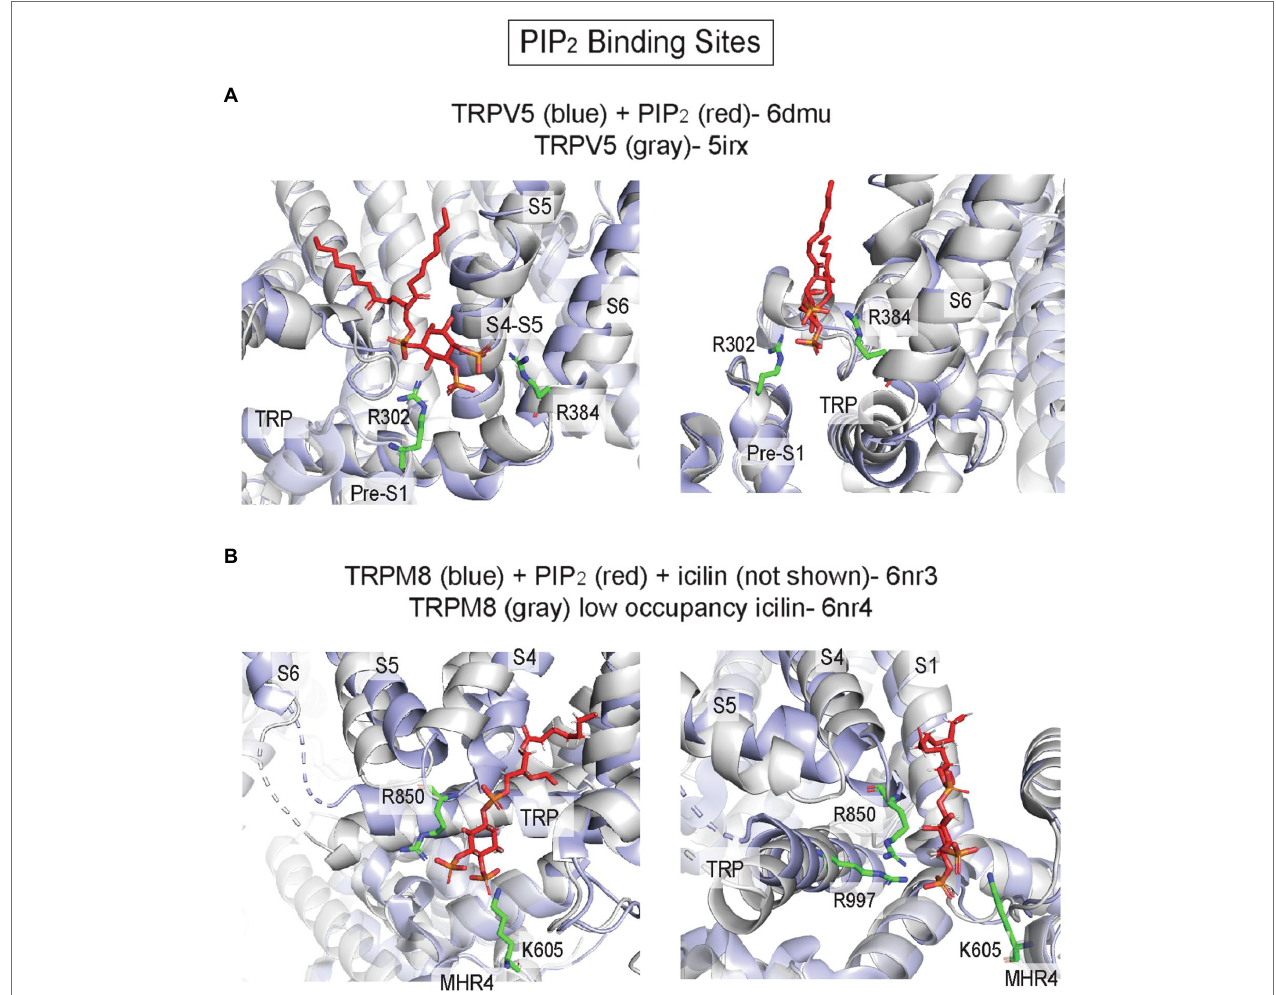
FIGURE 8 | PIP 2 binding sites in TRP channels. (A) TRPV5 with PIP 2 (pdb 6dmu) and TRPV5 without PIP 2 (pdb 5irx). R302 and R384 are predicted to interact with the